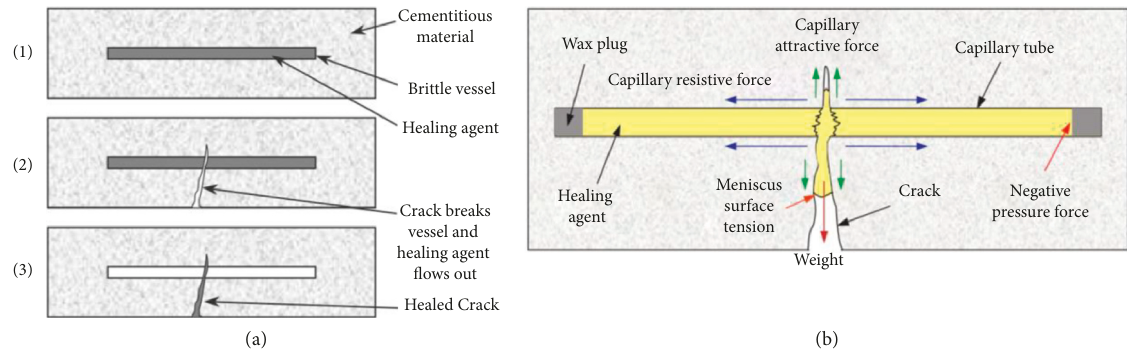
Figure 4: (a) Schematic diagram of the self-healing process. [24] (b) Schematic diagram of main forces acting on concrete cracks.